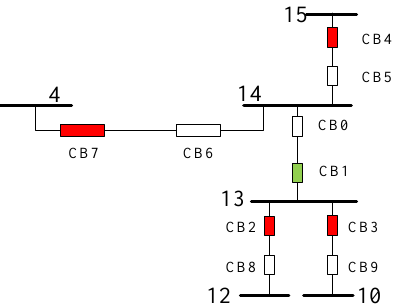
Figure 14. Fault area and circuit breaker state diagram.